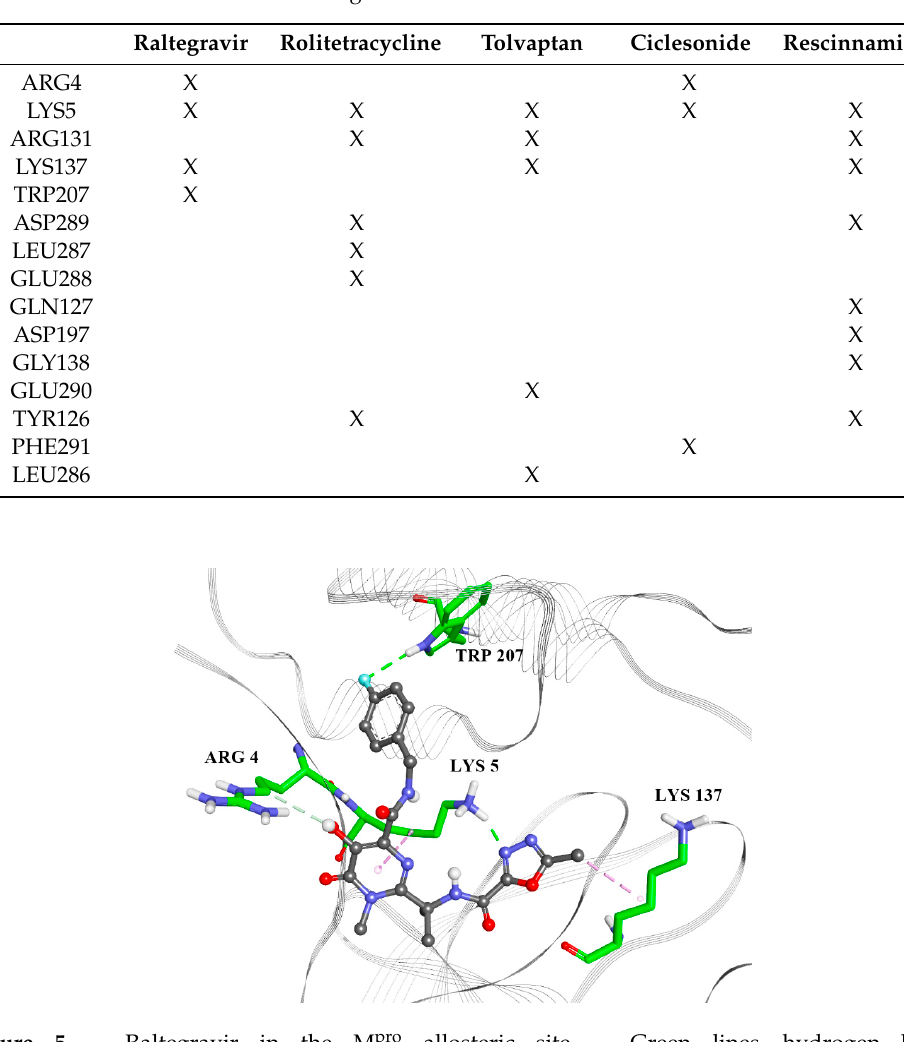
Figure 4. Mezlocillin in the M pro catalytic site. Green lines—hydrogen bonds; purple—alkyl- π interactions, magenta— π – π interactions, yellow—S– π interactions. Table 3. Protein – ligand interactions in the catalytic site. Table 4. Protein–ligand interactions in the allosteric domain.